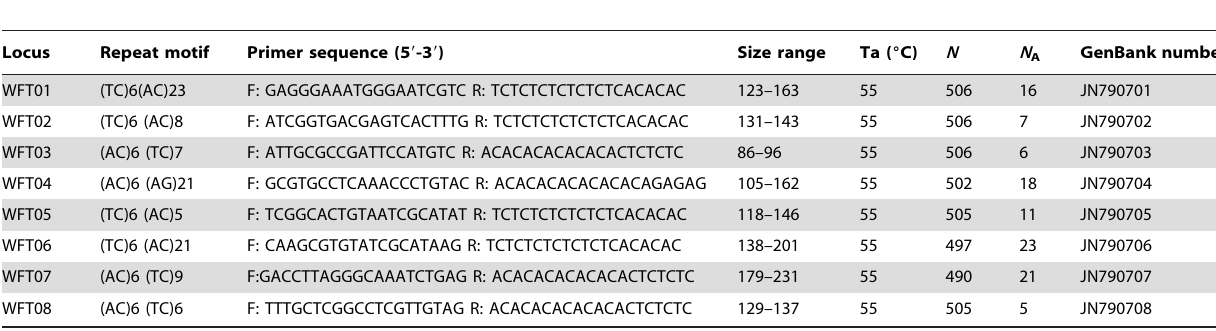
Table 2. Characteristics of eight new polymorphic microsatellite loci in Frankliniella occidentalis .